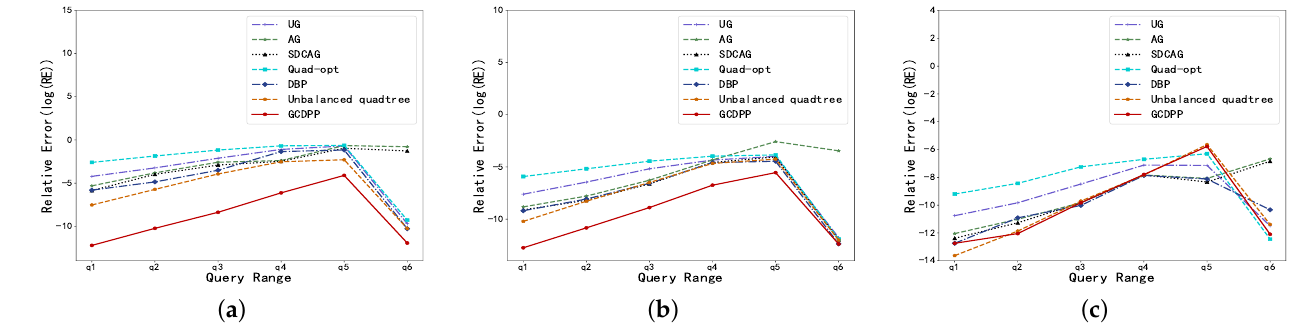
Figure 14. Comparison of querying accuracy on Yellow_trip dataset. ( a ) Yellow_trip dataset, (cid:101) = 0.01; ( b ) Yellow_trip dataset, (cid:101) = 0.1; ( c ) Yellow_trip dataset, (cid:101) = 1.